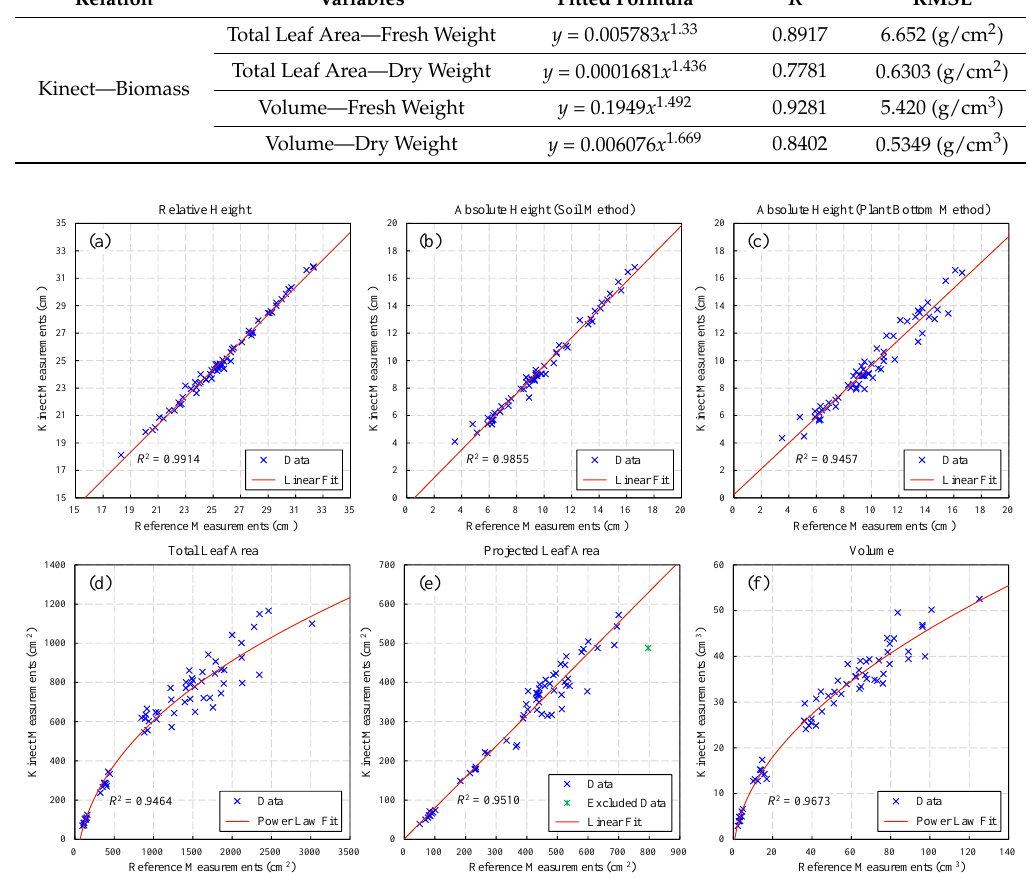
Figure 11. Data distribution and fitting results for relative height ( a ), absolute height based on soil method ( b ) and plant bottom method ( c ), total leaf area ( d ), projected leaf area ( e ) and volume ( f ). The original data for this figure can be found in Supplementary Material D. Mean absolute error (MAE) and mean absolute percentage error (MAPE) were used in Table 4 to show the accuracy of the Kinect measurements comparing to reference values for the data with linear relationships. All the three kinds of measured heights show good accuracy, where the relative height has the lowest MAPE (2.58%) and the soil method (absolute height) has the lowest MAE (0.4657 cm). For the relative height result, the existing error was mainly caused by random factors since the slope (1.002) of the fitted line is close to 1, but its intercept (−0.7111) could result from system error. For the result of absolute height with soil method, the main error source is the uneven soil surface, which could bring errors for both Kinect and manual measurements. For the result of plant bottom method, the error was mainly caused by the occlusion of leaves, because the actual bottom of the in-pot plant could be hidden by leaves. Table 4. Error of the measurements with linear relationships.